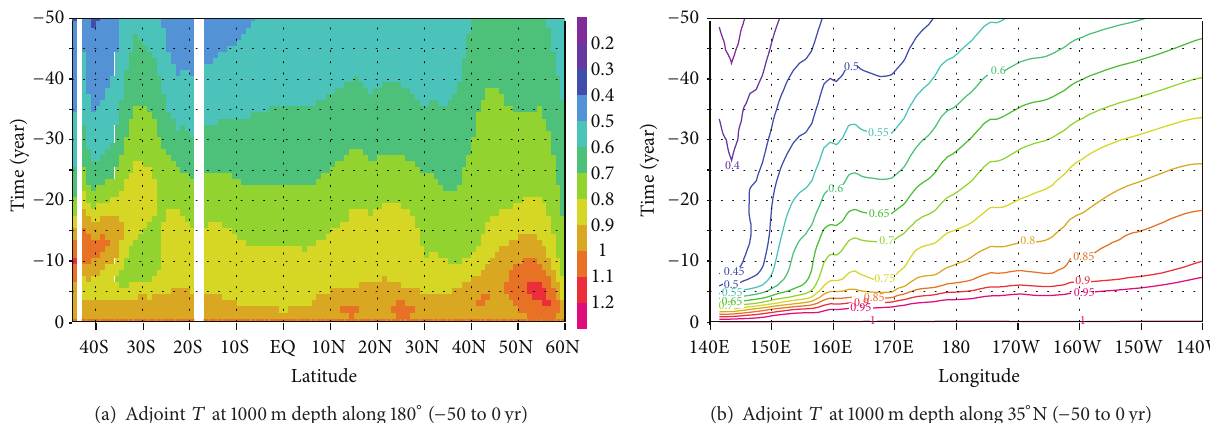
Figure 3: (a) Time-latitude plot of the sensitivities shown in Figure 2, from 45 ∘ S to 60 ∘ N on the 1000 m isobath along the International Date Line. (b) The same as (a) but for time versus longitude from 140 ∘ E to 140 ∘ W along 35 ∘